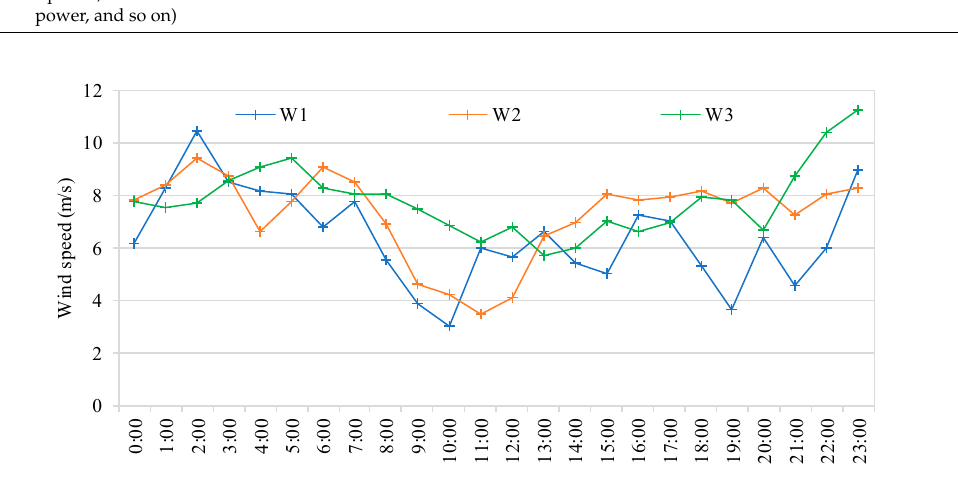
Figure A1. Wind speed of wind farm (source: POWERCHINA Kunming Engineering Corporation Ltd.).